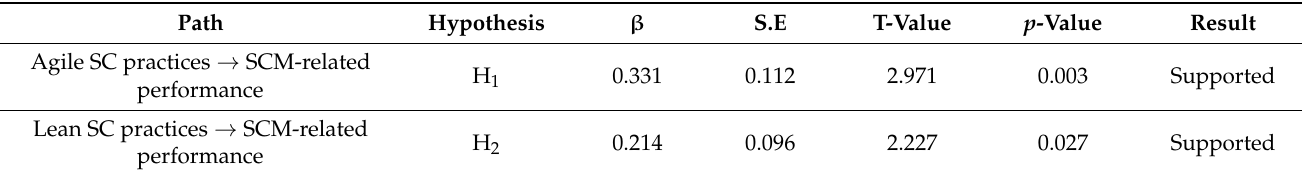
Table 5. Hypotheses